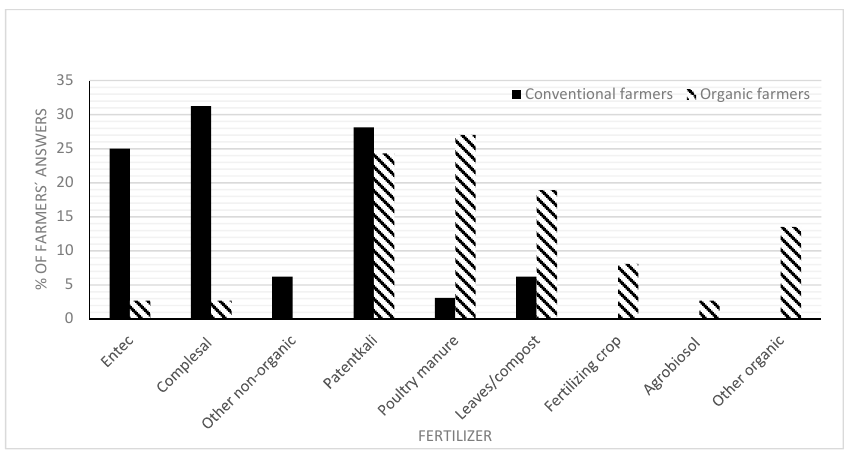
Figure 4. Fertilizers used by organic ( n = 16) and conventional ( n = 23) olive farmers in in Messenia, Greece.